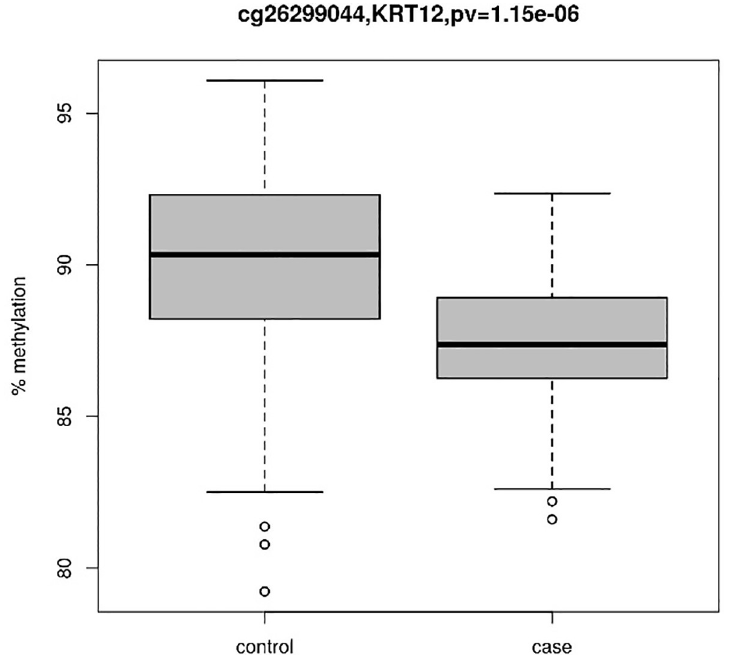
Fig 2. Methylation profiles of the significant CpG sites for myopic cases and